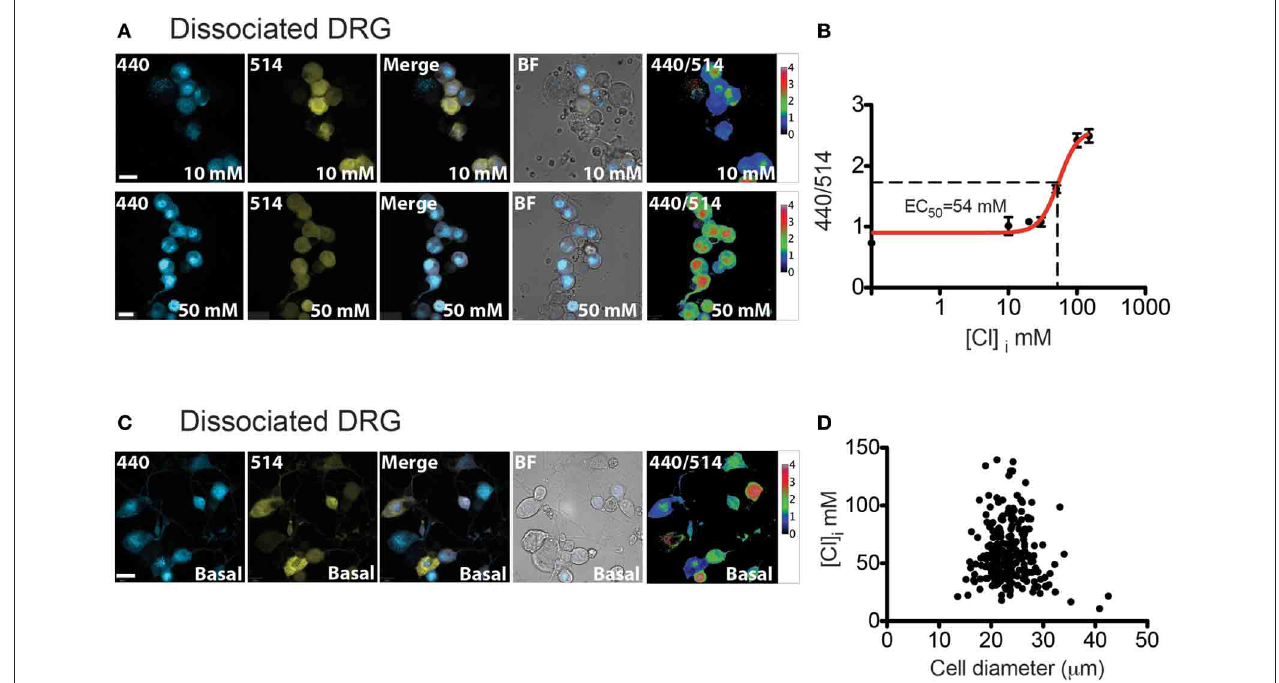
440/514 values were calculated at 0, 10, 20, 30, 50, 100, and 150mM [Cl] i ( n = 55). (C) Examples of [Cl] i measurement in DRG culture under basal conditions. From left to right: image captured with the 440nm laser (blue), 514nm laser (yellow), merged, bright field images and 440/514 images. Scale bar corresponds to 20 μ m ( D ) The relationship between cell size and [Cl] i in DRG neurons n =